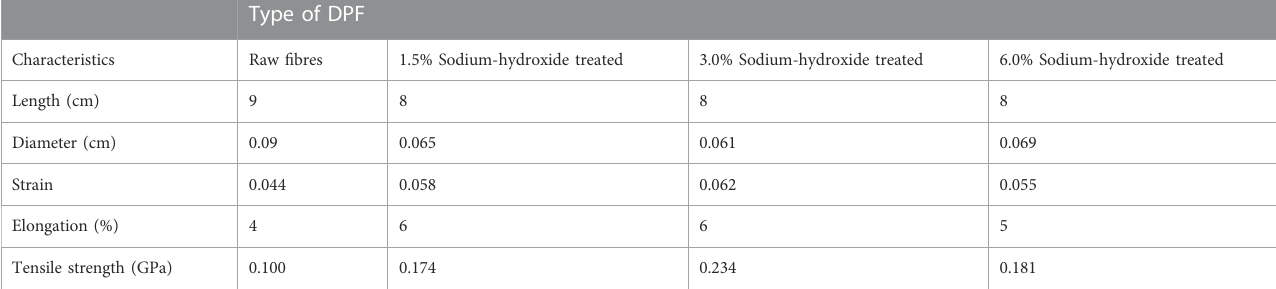
TABLE 6 Date palm fi bre ’ s physical characteristics.